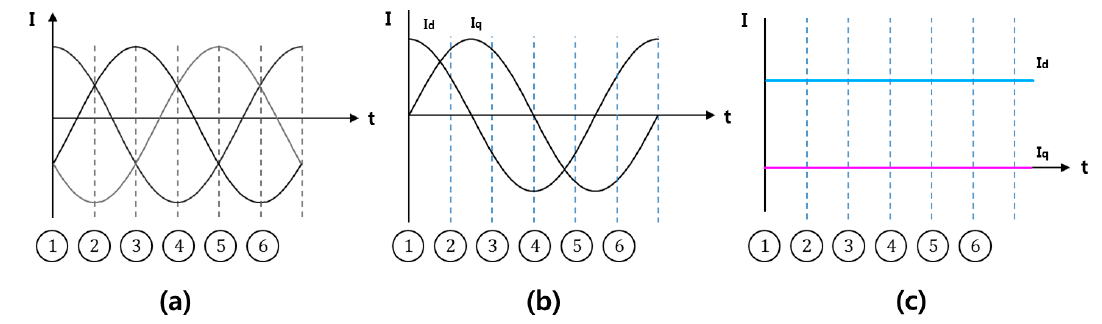
Figure 2. Direct-quadrature (D-Q) transformation process: ( a ) D-Q stationary reference frame ( b ) D-Q synchronous reference frame.